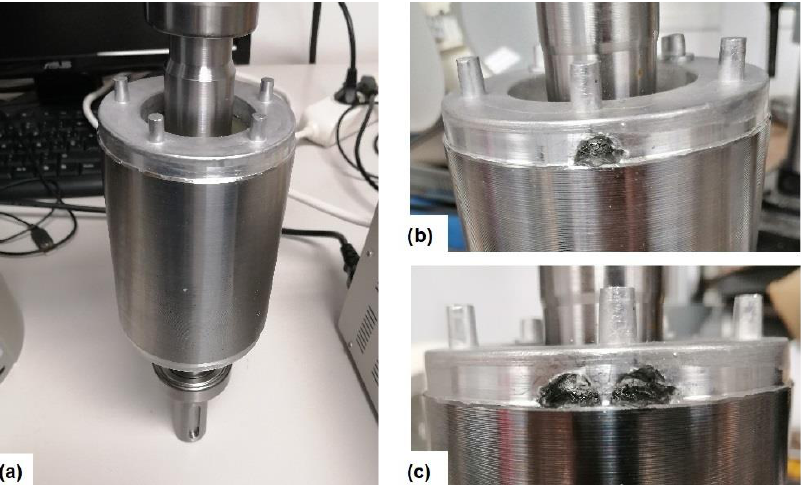
Figure 12. Detail of the rotor in the different health states: ( a ) Healthy. ( b ) One broken bar. ( c ) Two broken bars.